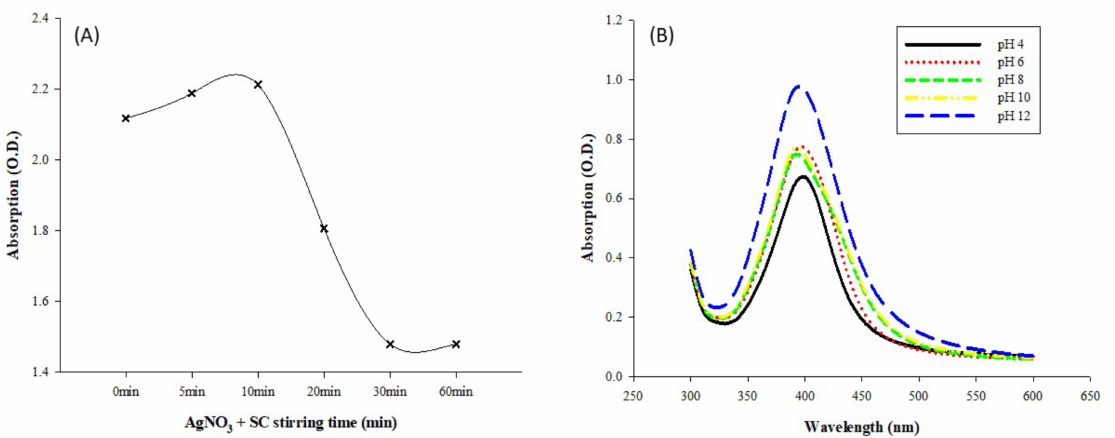
Figure 4. Effects of mixing time and pH on the generation of AgNPs: ( A ) UV–Vis absorption spectrum ( λ = 300–600 nm) of silver nanoparticles synthesized by silver nitrate, trisodium citrate, and sodium borohydride at different synthesizing times; and ( B ) UV–Vis absorption spectrum ( λ = 300–600 nm) of silver nanoparticles synthesized by silver nitrate, trisodium citrate, and sodium borohydride in different pH value solutions (pH 2–12).